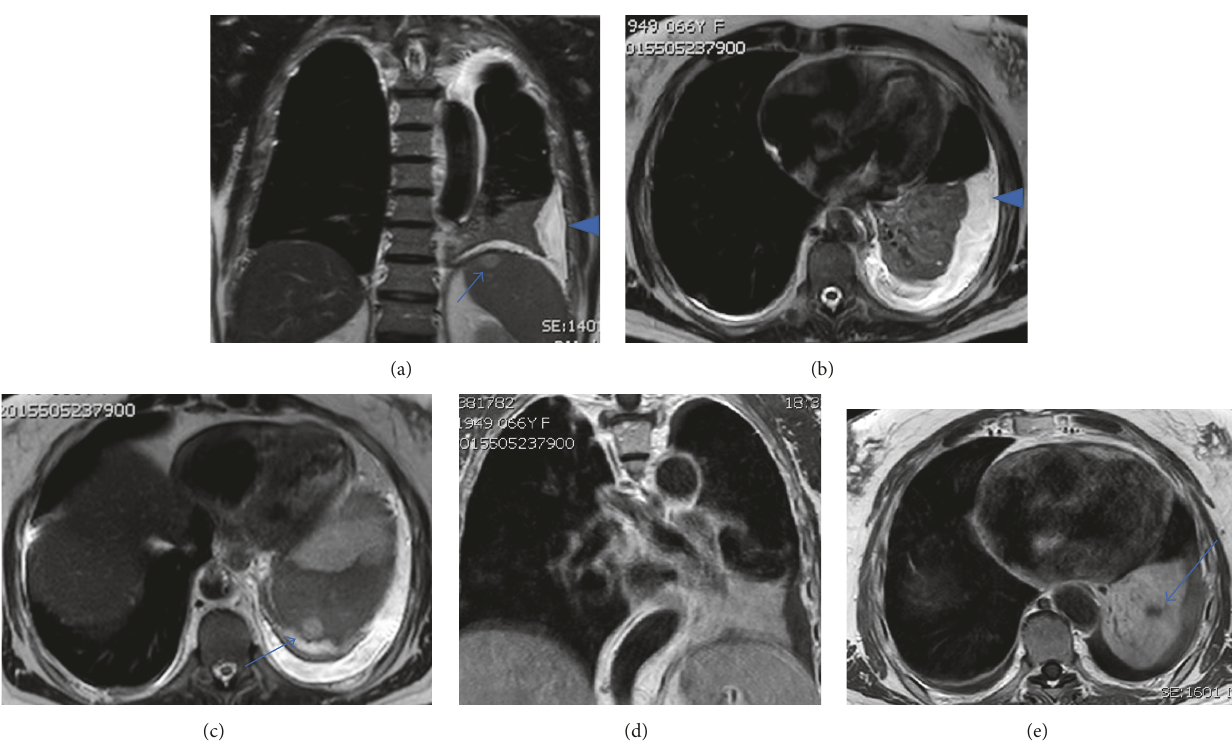
Figure 10: Thoracic MR images. Fluid sensitive sequences (a–c) show the presence of left pleural effusion (arrowhead) and also the nodular lesions in the spleen, which do not correspond to cysts (arrows). T1 weighted images with contrast (d and e) show the pulmonary mass and hypodense zones representing necrotic areas